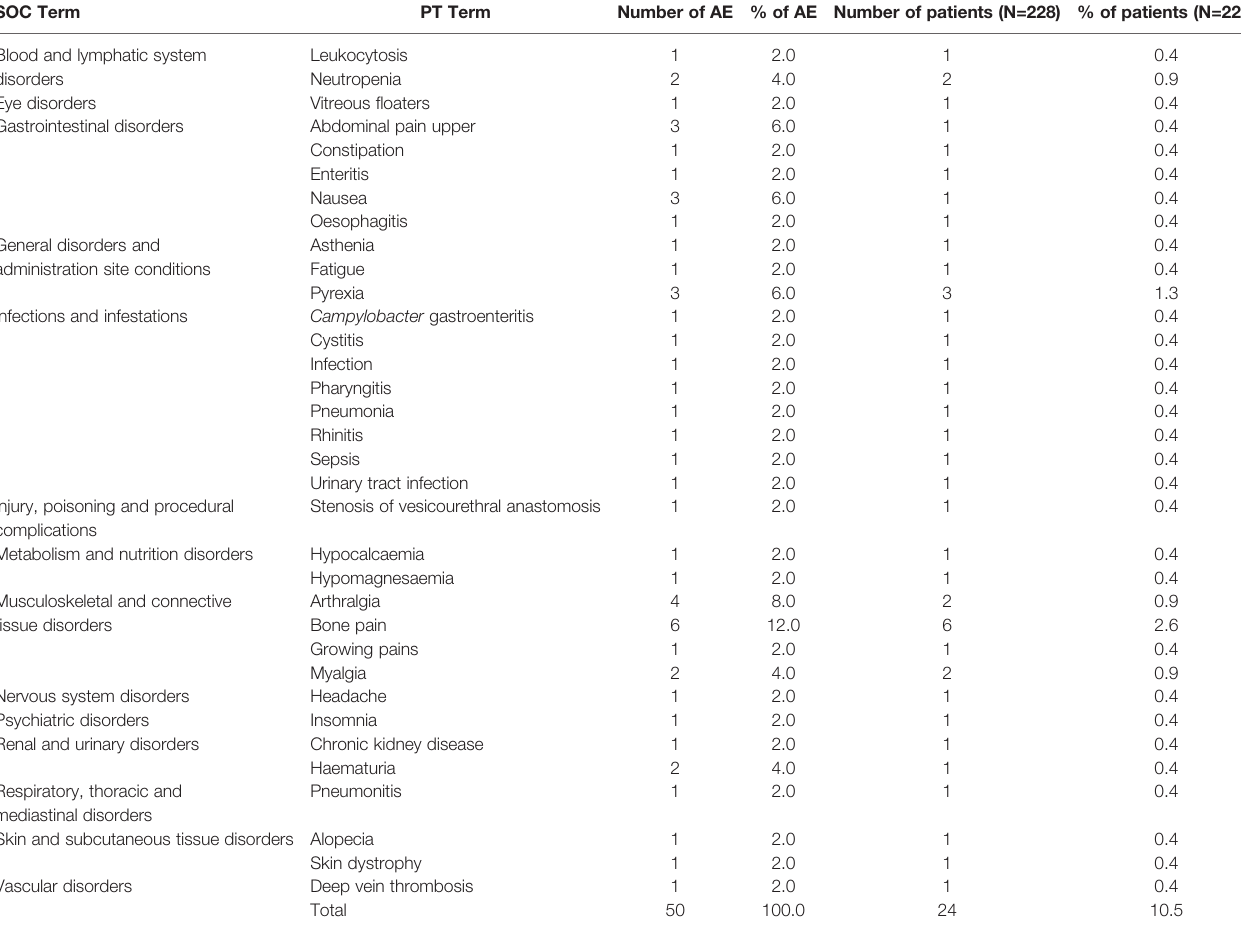
TABLE 5 | Adverse reactions coded in System Organ Classes and Preferred